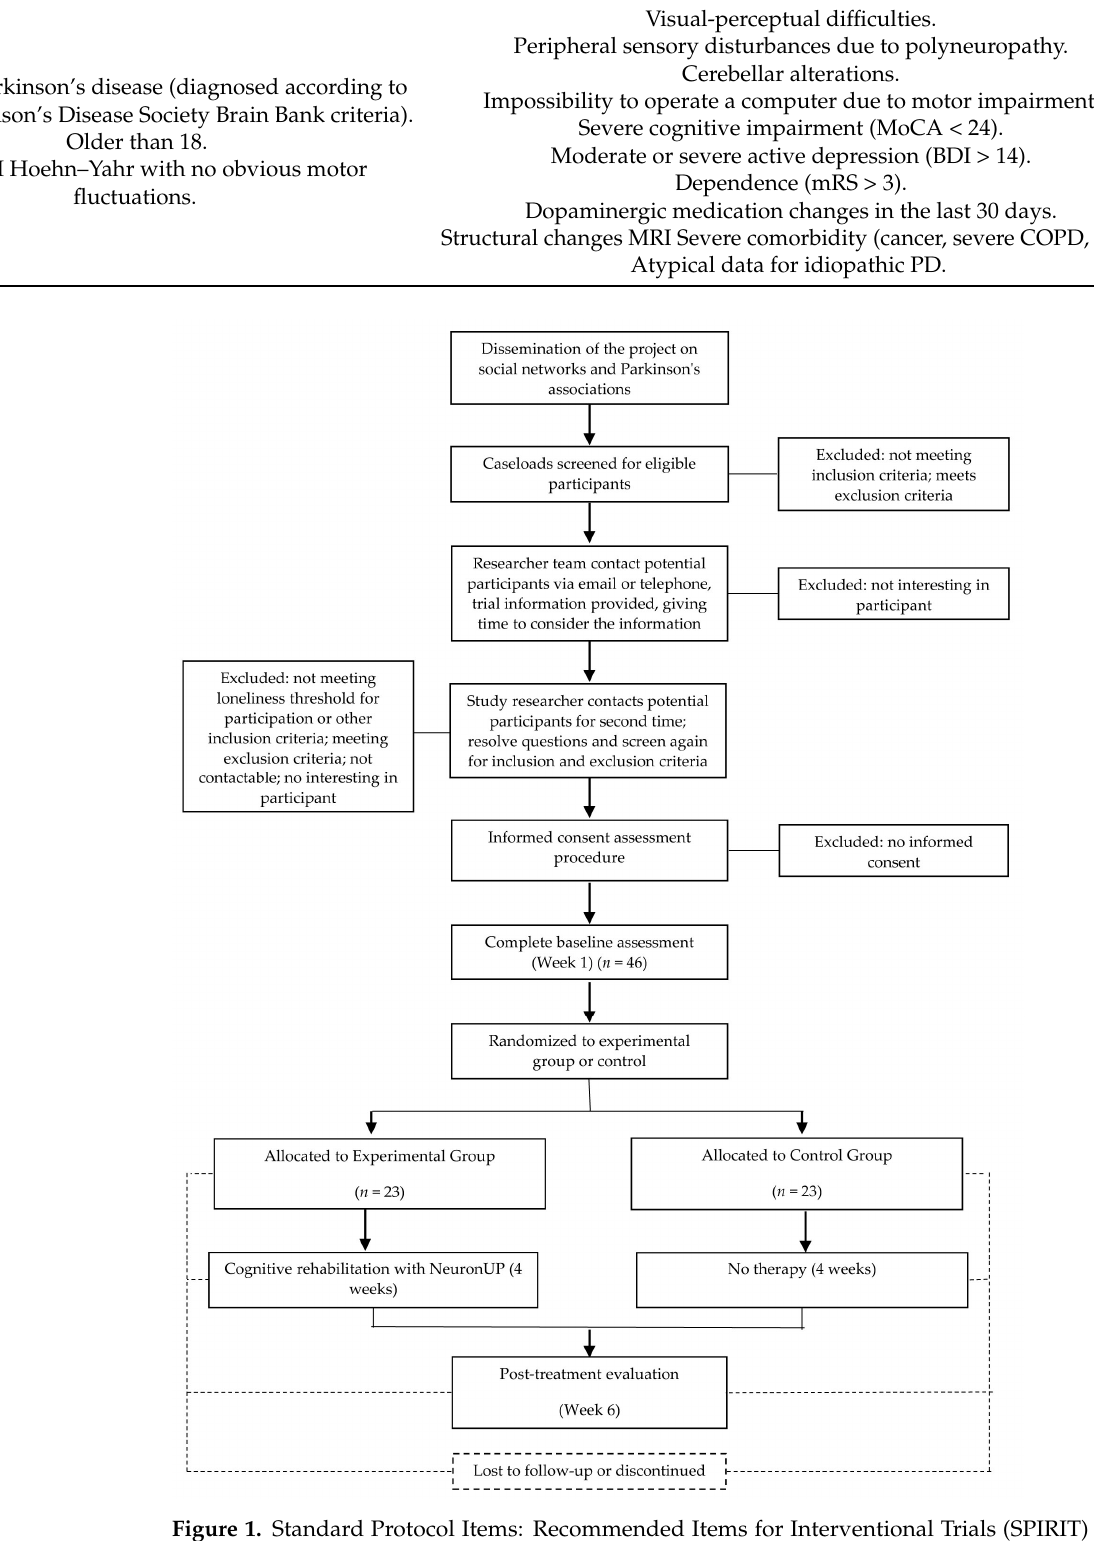
Figure 1. Standard Protocol Items: Recommended Items for Interventional Trials (SPIRIT) study flow chart.